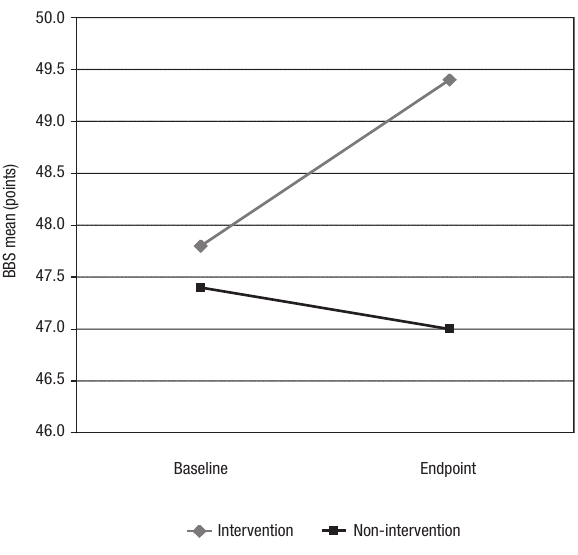
Graph 1. Berg Balance Scale (BBS) mean scores at baseline and endpoint.